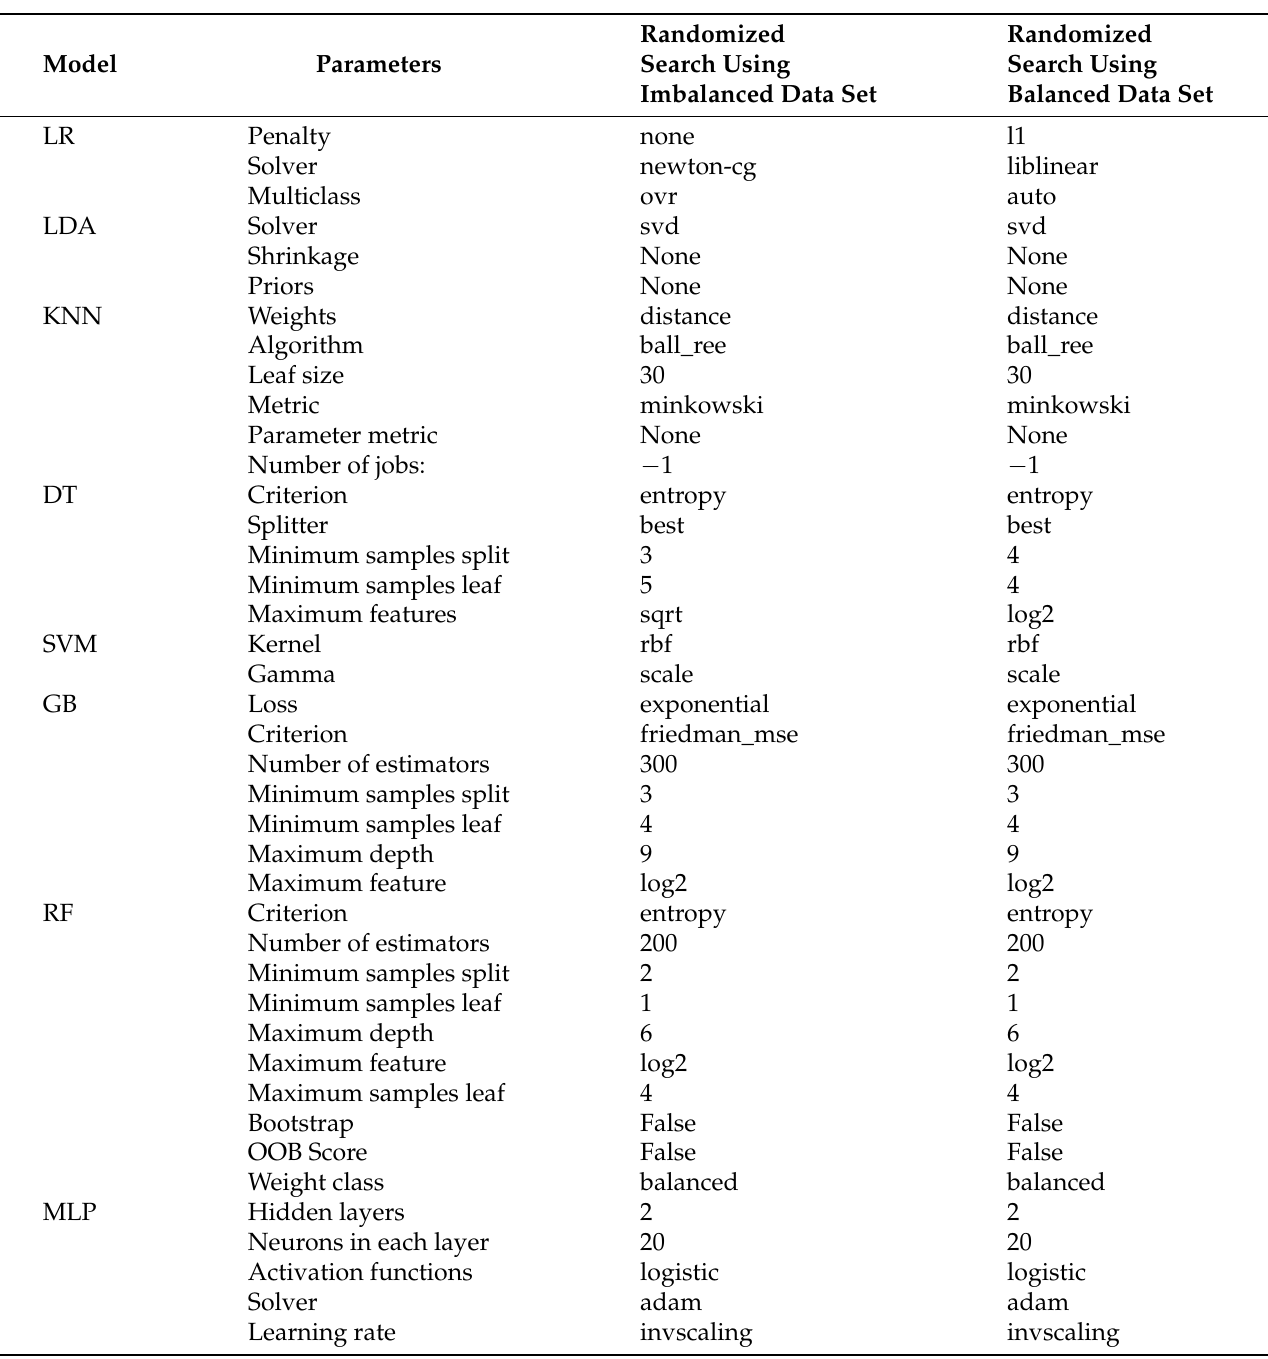
Table 3. Hyperparameter configuration selected by the randomized search